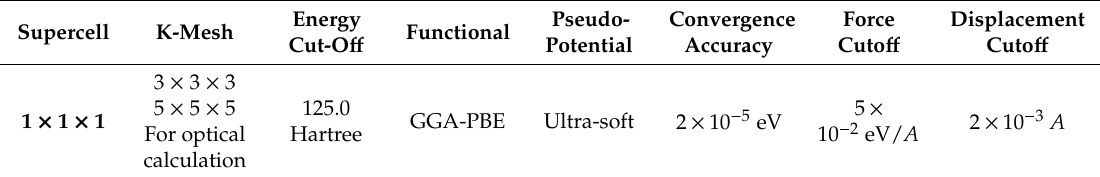
Table 2. Density functional theory ( DFT) calculation parameters for ground state energy and geometry